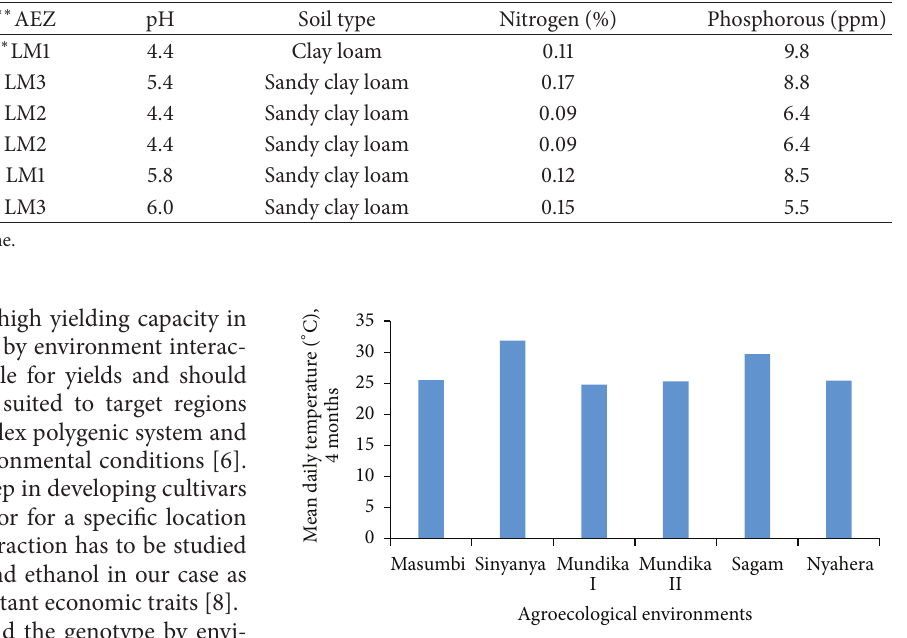
Table 1: Description of soil components of testing locations.